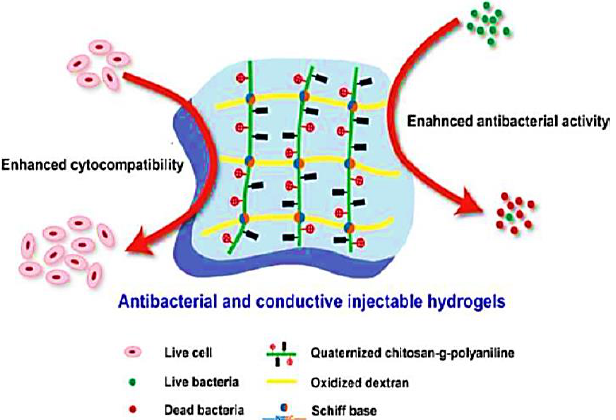
Figure 3. Antibacterial activity of a polyaniline nanomaterial [97]. Reproduced with permission from Elsevier.